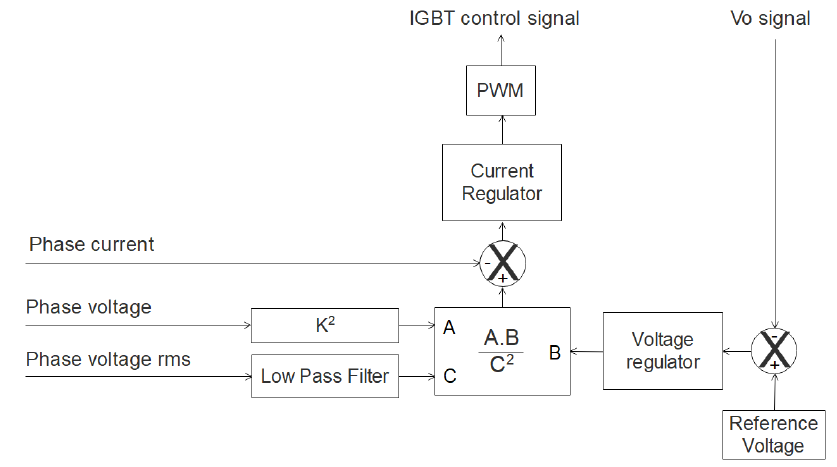
Figure 7. Basic diagram of UC3854B control.